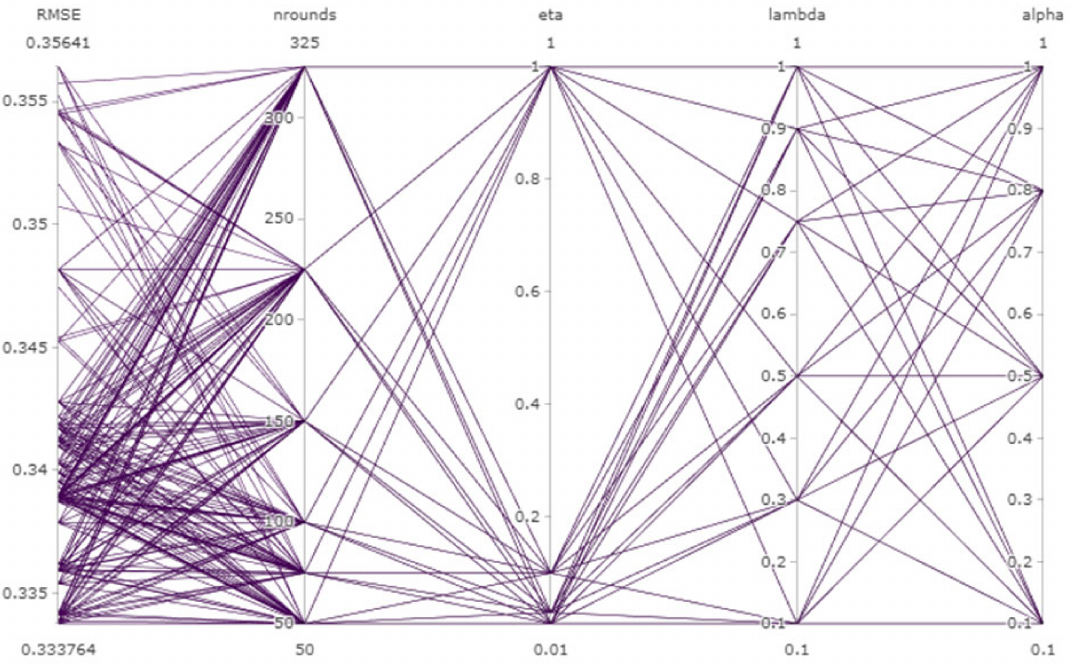
Figure 4. Interactions between hyperparameter values based on the grid search algorithm in the extreme gradient-boosting